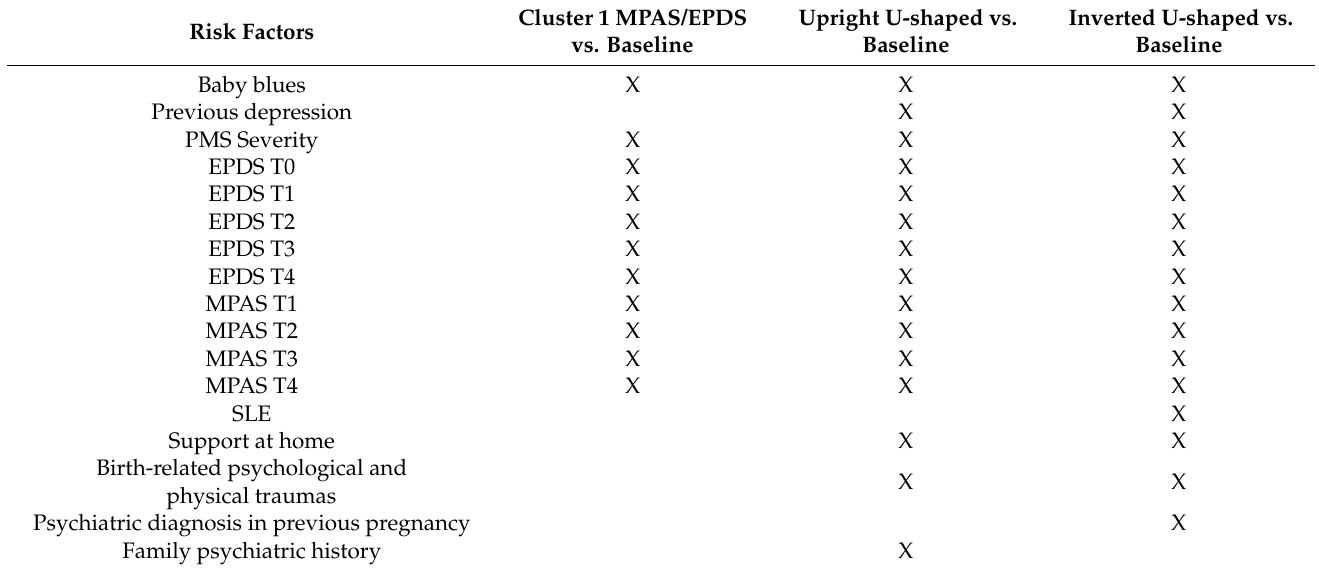
Table 2. Risk factor comparison of the clusters with the baseline MPAS/EPDS cluster. Cluster 1 MPAS/EPDS Upright U-shaped vs. Inverted U-shaped vs. Risk Factors vs. Baseline Baseline